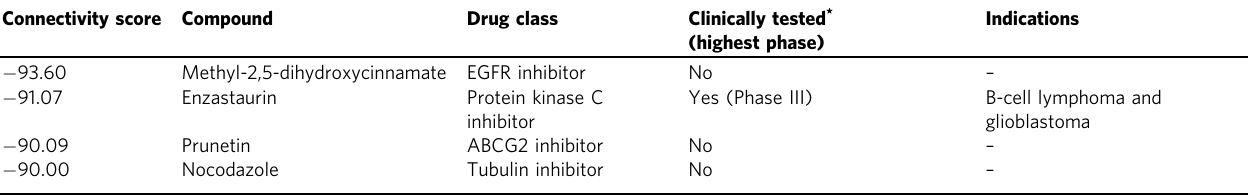
Table 3 Connectivity Map compounds with gene expression pro fi les opposing endometrial cancer risk TWAS associations. Connectivity score